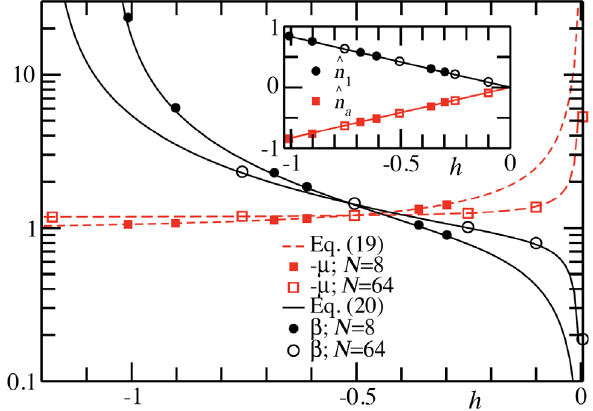
FIG. 3. The numerical values of chemical potential − μ (red squares) and inverse temperature β ¼ 1 =T (black circles) versus the theoretical predictions Eq. (19) (red dashed line) and Eq. (20) (black lines), respectively. Filled symbols correspond to N ¼ 8 , while open symbols correspond to N ¼ 64 . Inset: The numeri- cally extracted optical powers (symbols) scaled as ˆ n 1 and ˆ n α versus the averaged energy density h . The rescaled ˆ n 1 reaches the value zero at h ¼ h . The solid lines are the theoretical max predictions of Eq. (13) while the two types of symbols correspond to N ¼ 8 (filled symbols) and N ¼ 64 (open symbols). In all cases we considered an initial optical power a ¼ 1 , coupling constant J 0 ¼ 1 . 2 , while the nonlinearity is weak, χ ¼ 0 . 01